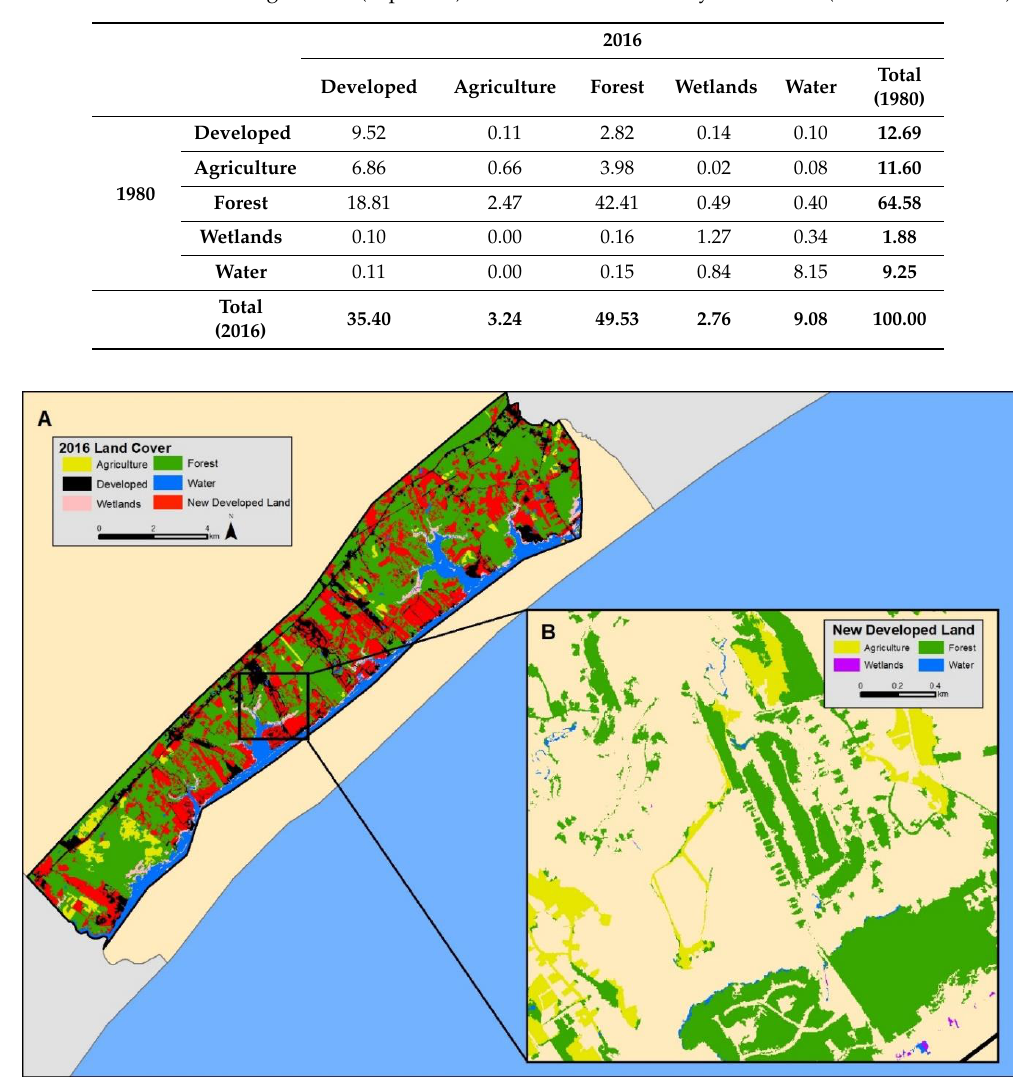
Figure 8. Coastal land cover classification where (A) is the 2016 land cover dominated by widespread new urban development (red) and (B) is a closer look at new urban development from 1980 to 2016 where the main loss to urban areas was forest (green) and agriculture (yellow). A statistical comparison between the land cover changes in the county versus the coast showed that there was low correlation (correlation coefficient = 0.49195) and low regression (R 2 = 0.3919), but an ANOVA determined that there was no statistical difference between the two change matrices. It is expected that the two change matrices (county and coast) should not be statistically different given their geographic proximity; however, there are clear differences between the two as described above. Therefore, an ANOVA comparison using only the changes (off-diagonals) showed that there was a significant difference between the county and the coast (p = 0.078). The county was dominated by changes in forest while the coast had the largest change in urban growth, and even though the change in wetlands was small (1.02% in the county and 2.28% in the coast), the change in wetlands was significantly different along the coast in comparison with the inland part of the county. Regarding